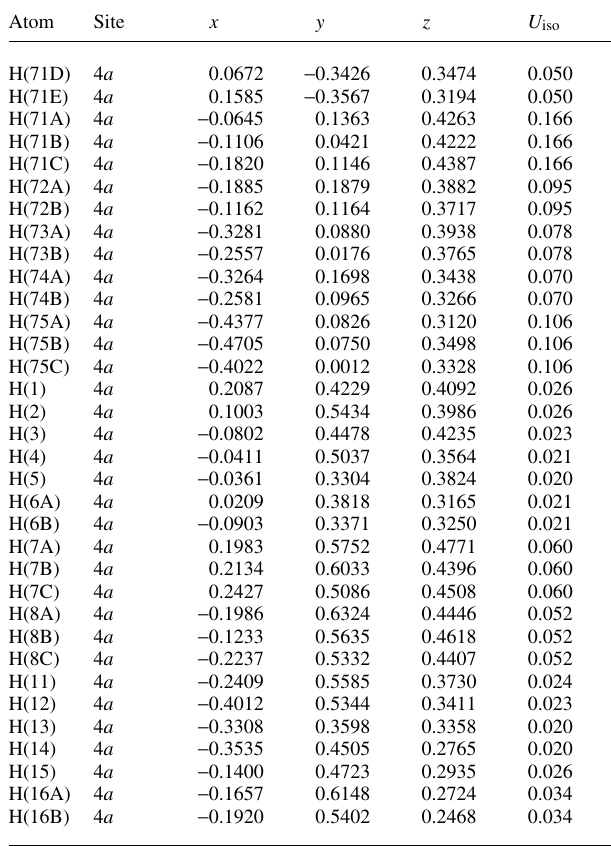
Table 2. Atomic coordinates and displacement parameters (in Å 2 )